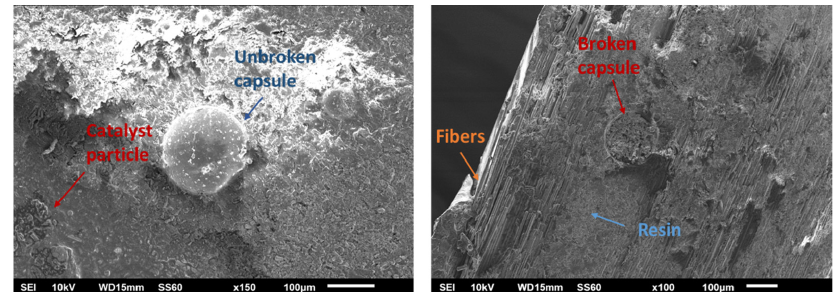
Figure 15. SEM images from mode-II specimens before ( left ) and after ( right ) healing.